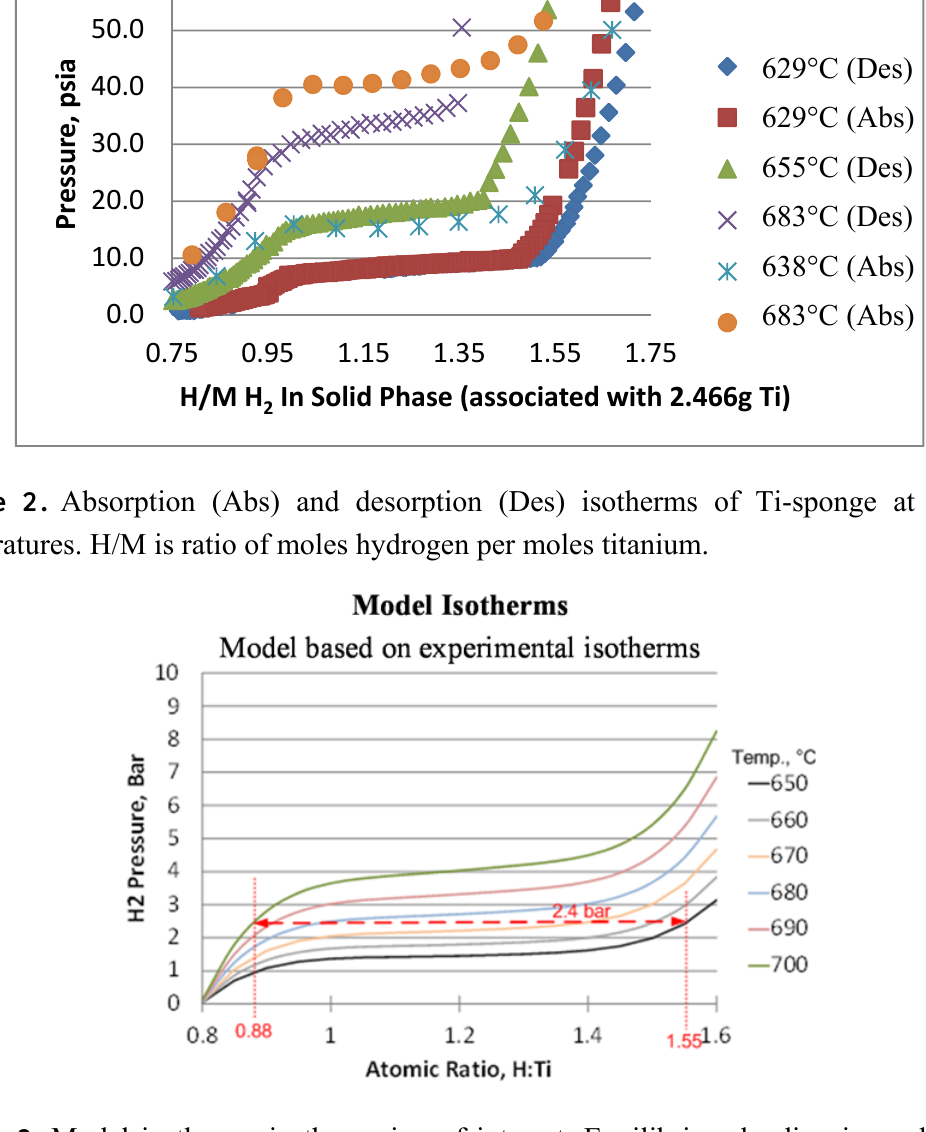
Figure 3. Model isotherms in the region of interest. Equilibrium loading is predicted to swing from 0.88 mol H:mol Ti at 700 °C to 1.55 mol H:mol Ti at 650 °C for a swing of 0.67 mol Hmol Ti. Actual loading swings achieved in the model depend on local temperatures reached during the loading/unloading